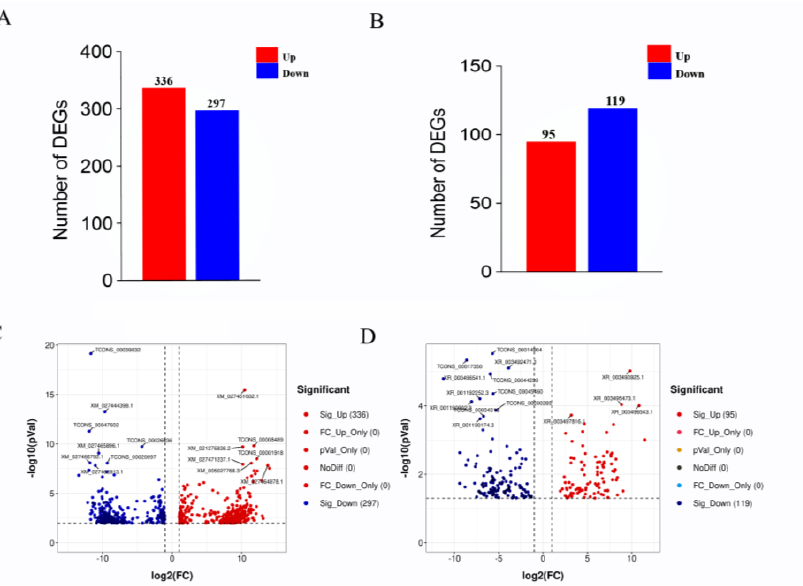
Figure 2. The expression of differential mRNA (DEGs) and differential lncRNA (DELs) in the high and low abdominal fat rate groups. Note: ( A ) Statistics on the number of DEGs in the high and low abdominal fat rate groups; ( B ) statistics on the number of DELs in the high and low abdominal fat rate groups; ( C ) volcano map of DEGs, the y axis is the value of − log10 ( p Value), the x axis is the value of log2 (FC), and the two threshold lines respectively represent p = 0.01 and FC = 2; ( D ) volcano map of DELs, the y axis is the value of − log10 ( p Value), and the x axis is the value of log2 (FC). The two threshold lines respectively represent FDR = 0.05 and FC = 2.